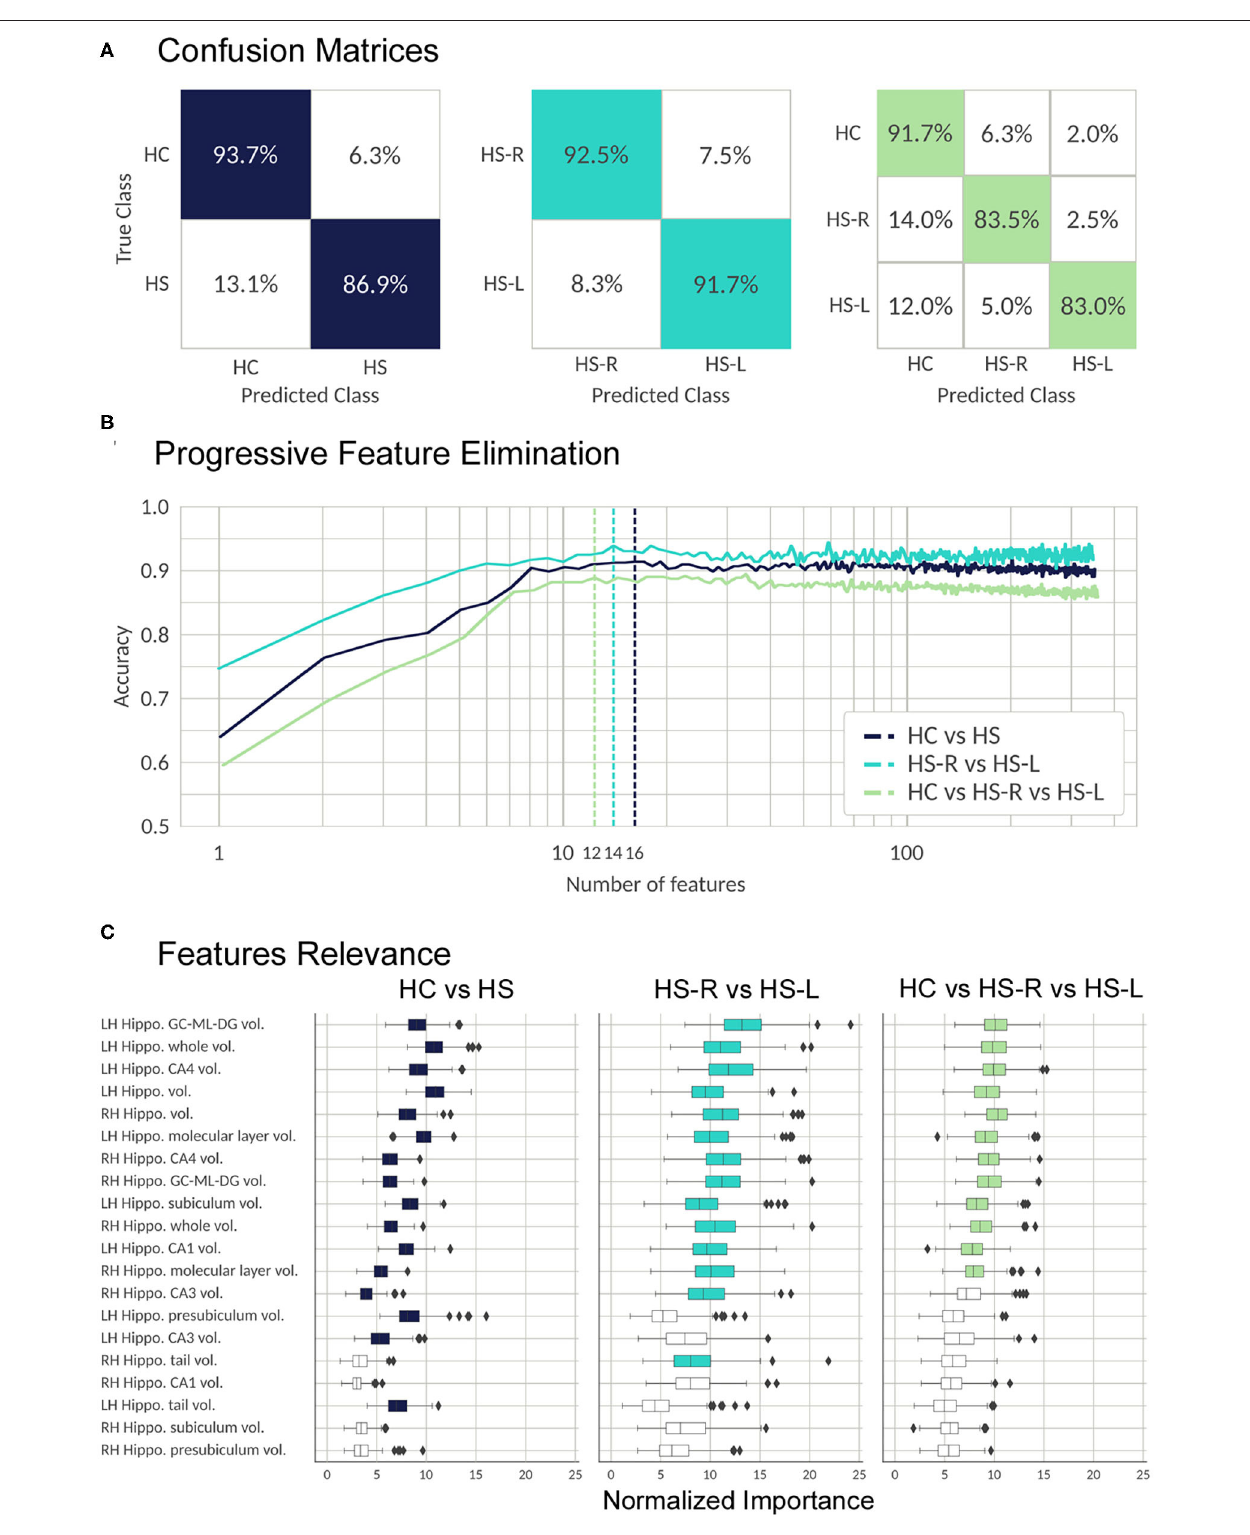
FIGURE 4 | Validation process; results from the RFC algorithm. (A) Random forest performance. The confusion matrices show the percentage of correct (colored) and incorrect predictions for each class. The value was accumulated over the Monte Carlo cross validation (200-folds). (B) Progressive feature elimination. Random